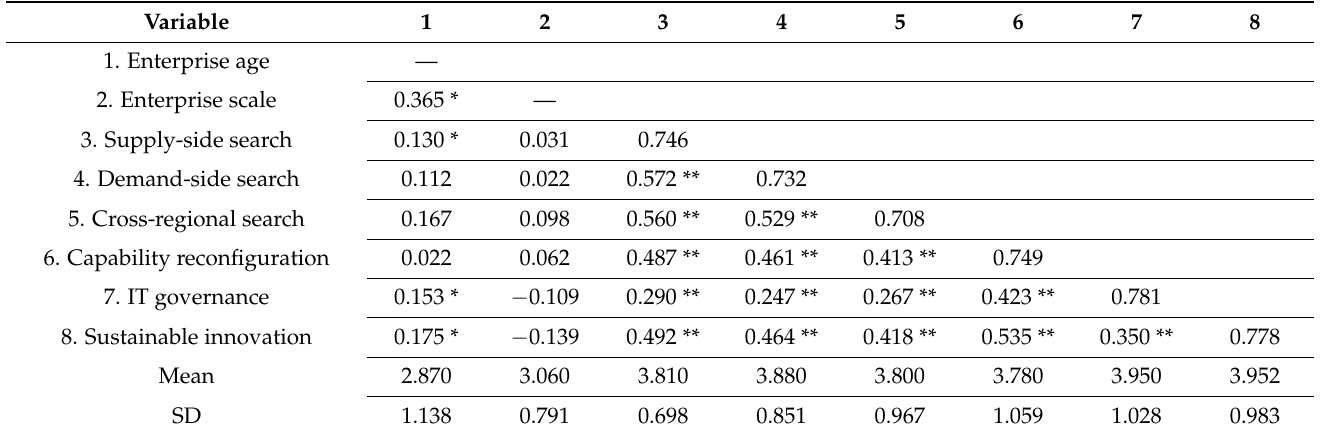
Table 4. Descriptive statistics and correlation analysis results ( n = 269).